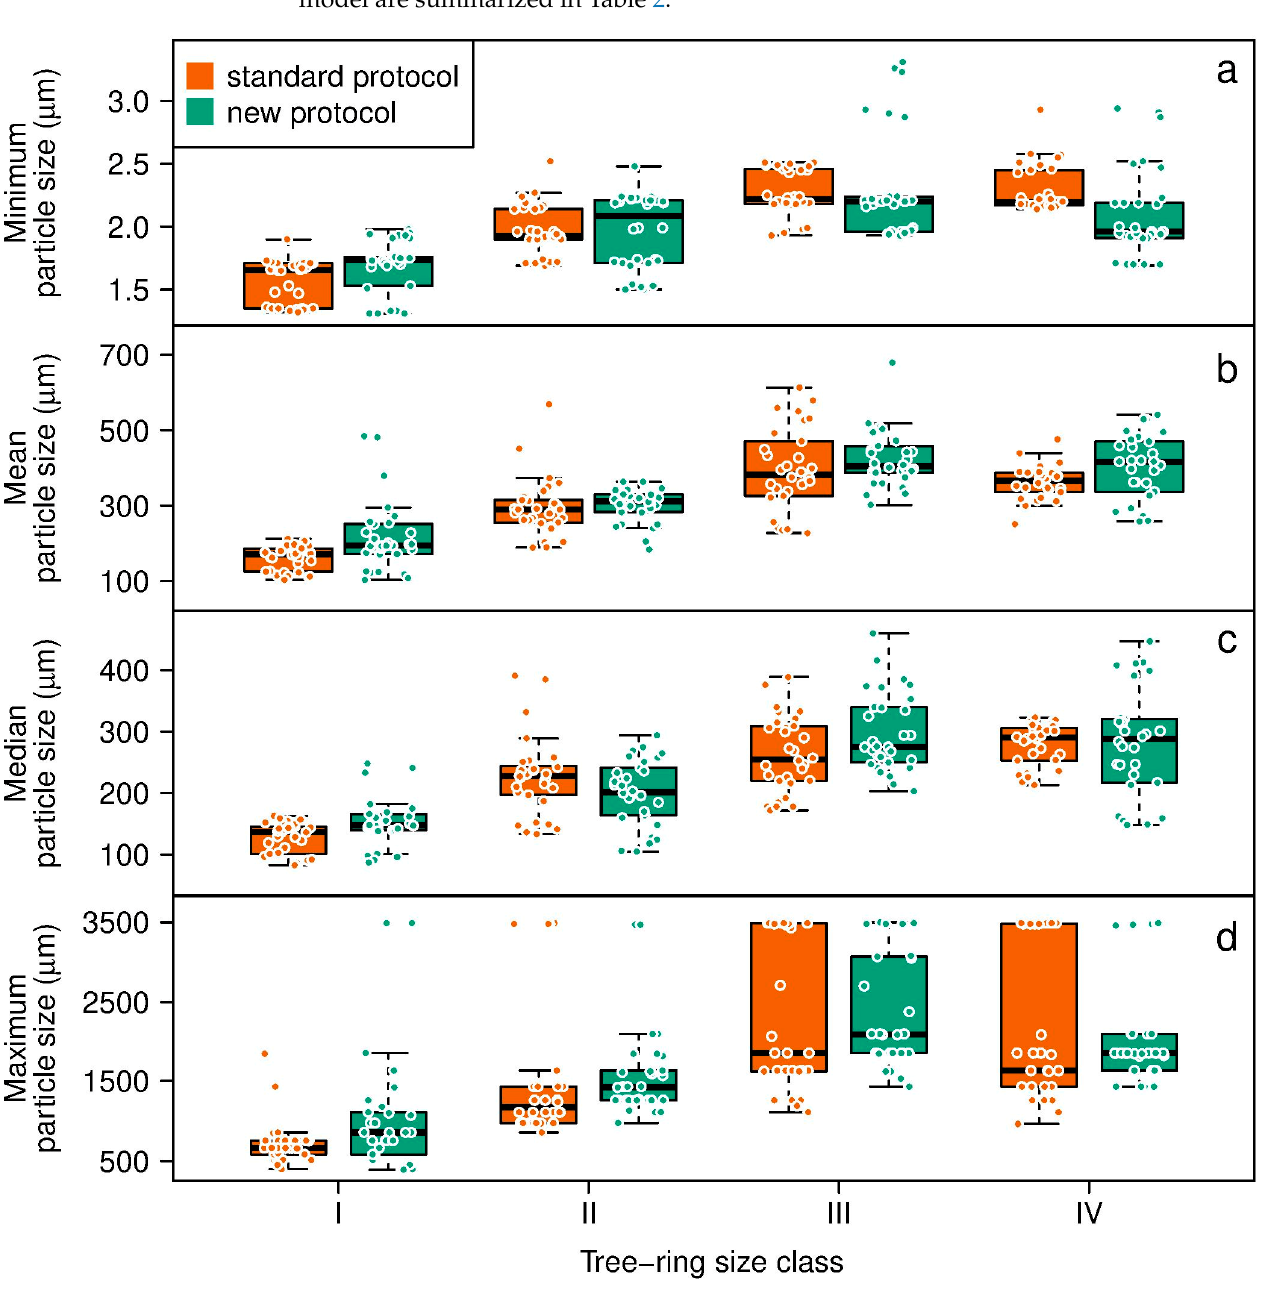
Figure 2. Box plots showing the minimum particle size ( a ), the mean particle size ( b ), the median particle size ( c ), and the maximum particle size ( d ) in each dimensional class of tree ring width (I, II, III, IV), comparing the standard and the new protocol. In each boxplot, data were also added by jittering coordinates along the x-axis. Measurements of particle size are in microns ( µ m). The range of detectable particle sizes by laser diffraction particle size analyzer is 0.01–3500 µm.